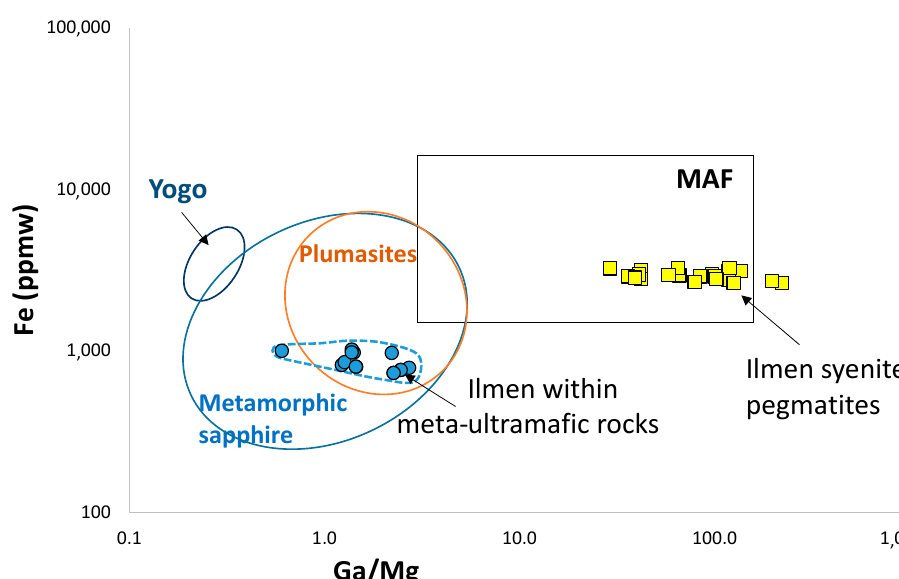
Figure 6. A plot of Ilmen sapphires within meta ‐ ultramafic host rocks (bold blue circles) in a Fe versus Ga/Mg diagram showing boundaries for magmatic (MAF: Main Asian Field; magmatic sapphires in alkali basalt) and metamorphic sapphires are modified after [14,19]. Ilmen sapphires that plots from syenite pegmatites is from [6].